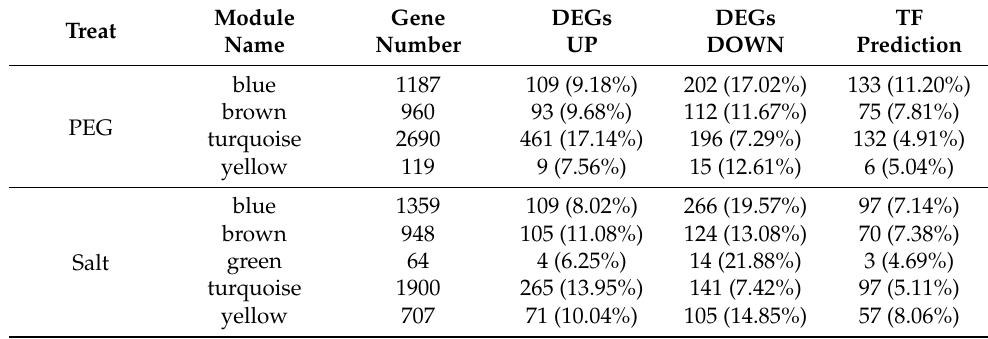
Table 1. Genes distribution in the co-expression